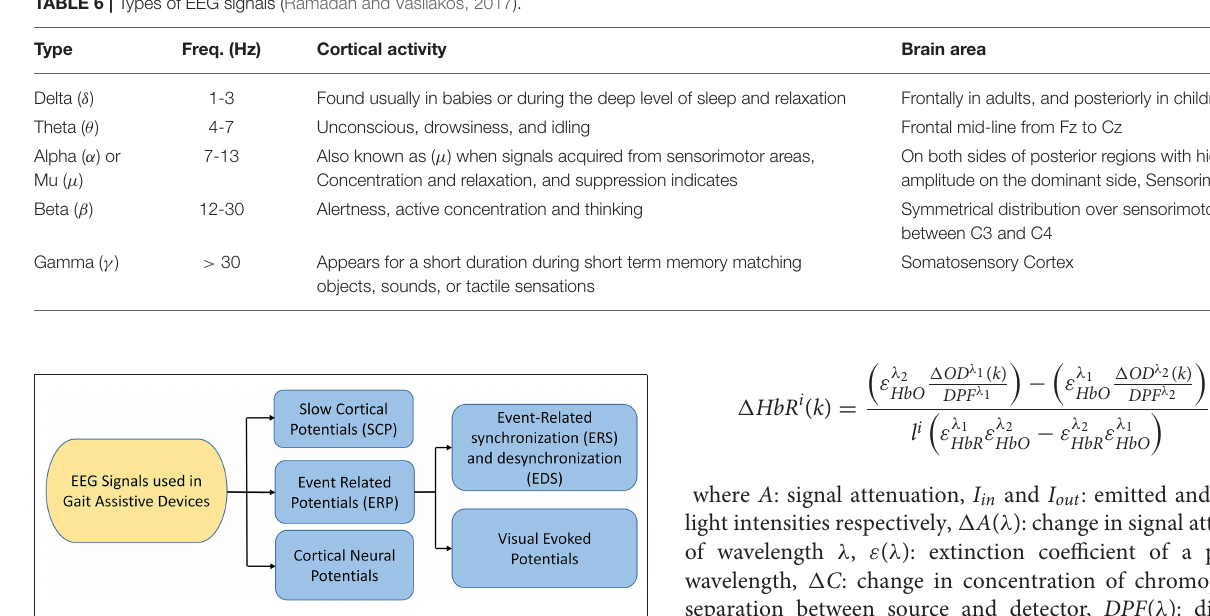
TABLE 6 | Types of EEG signals (Ramadan and Vasilakos, 2017).